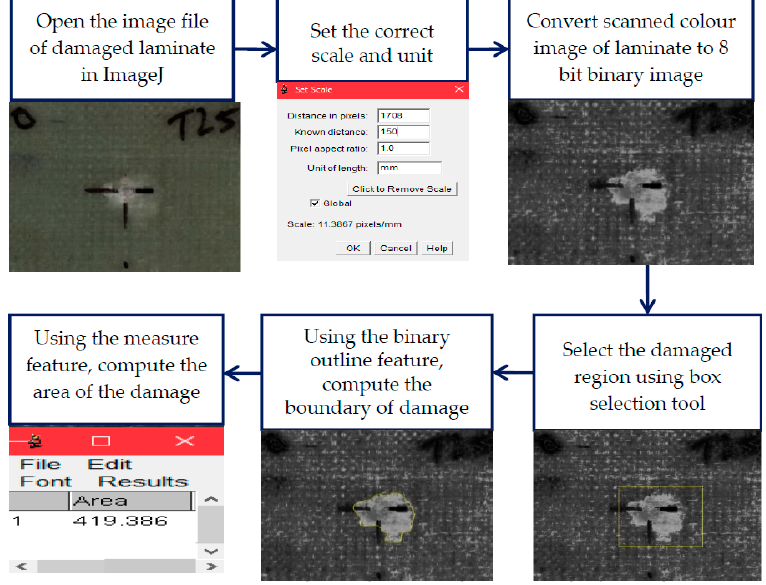
Figure 2. Image analysis technique used to compute the damaged area.